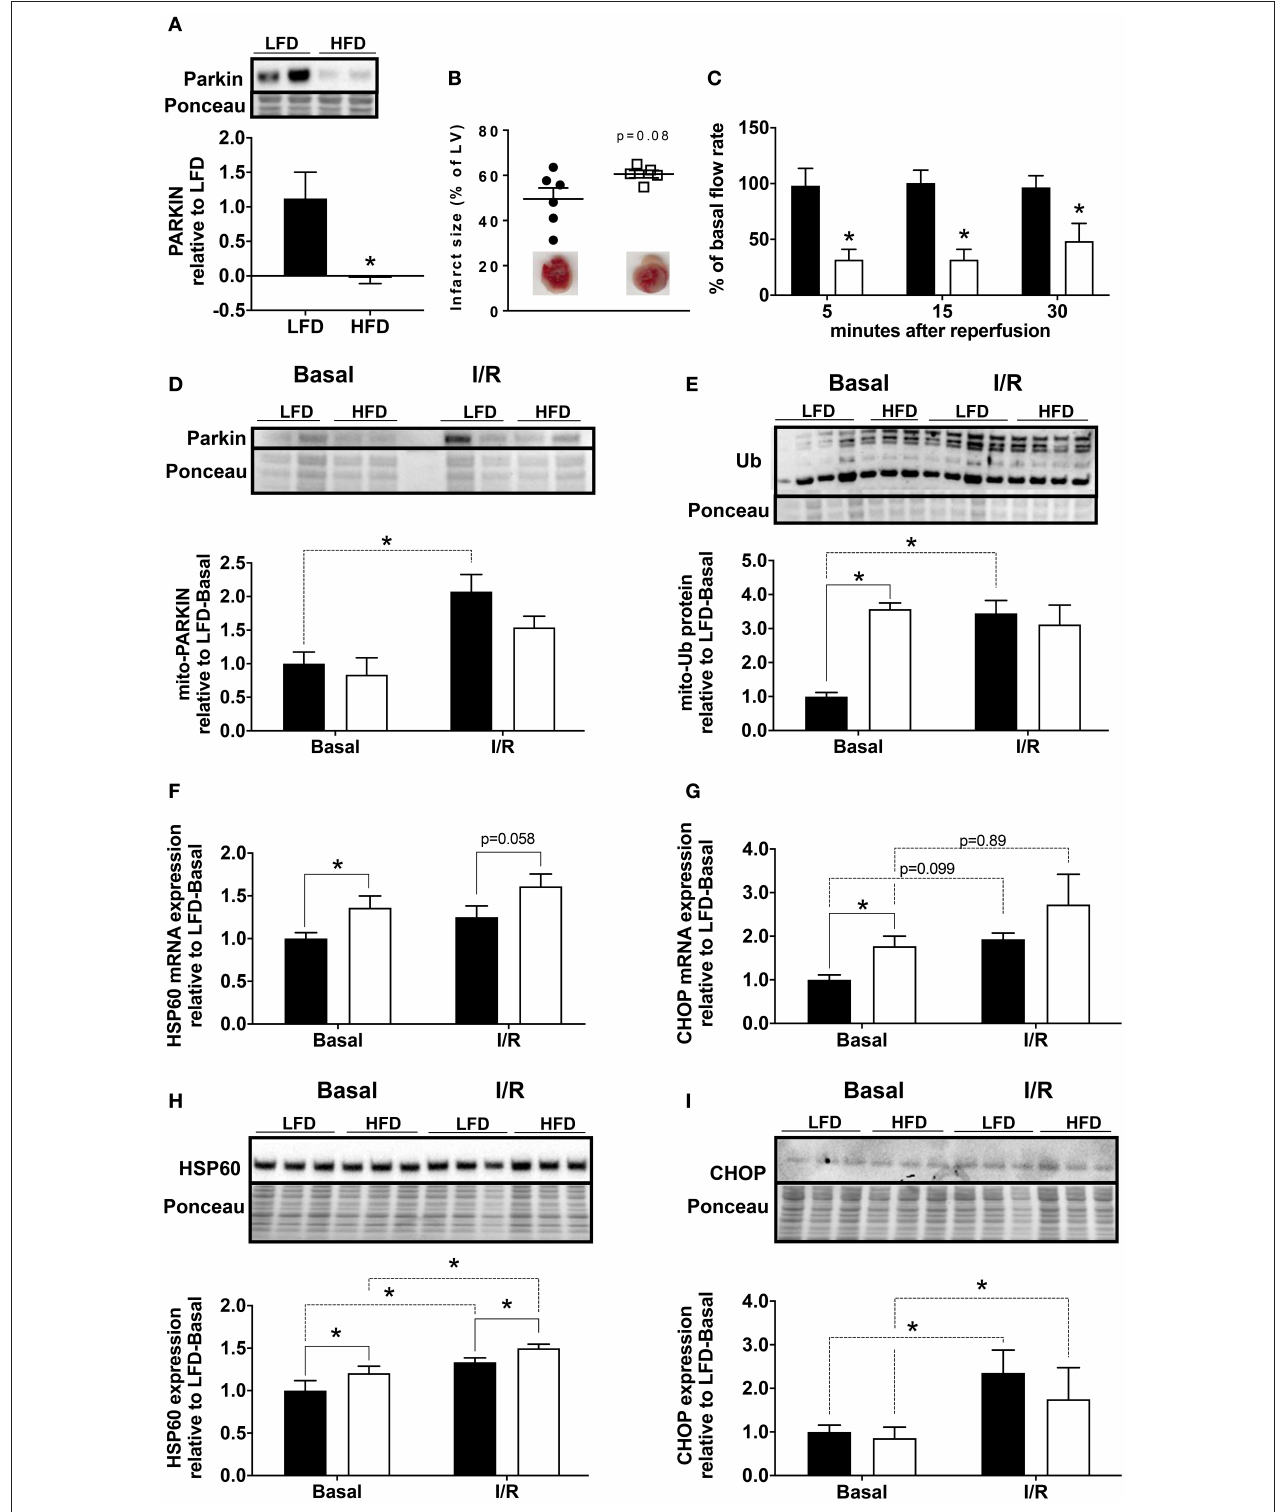
FIGURE 2 | Loss of Parkin, cardiac and mitochondrial homeostasis alteration in HFD mice subjected to ischemia/reperfusion (I/R). Protein expression of Parkin was quantified by densitometric analysis of Western blots of heart lysates (A) from LFD and HFD mice after I/R. Infarct size was determined by colorimetry and